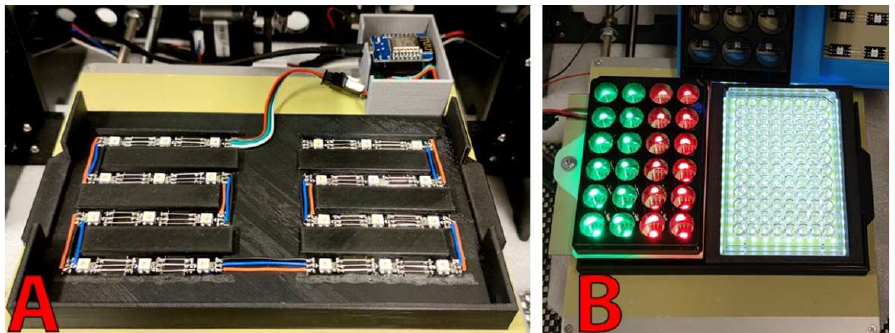
Figure 5. Sample holder and lighting systems. RGBW LEDs were mounted on the sample holder to illuminate individual wells of two 12-well clear-bottom plates ( A ); 24- or 96-well plates can also be used ( B